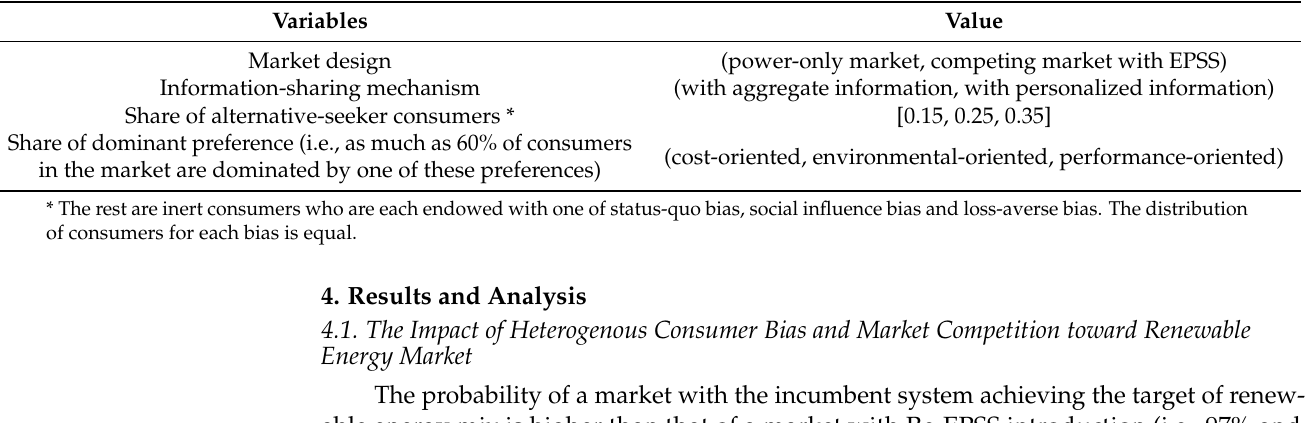
Figure 3. Market condition effect on storage capacity. On the other hand, EPSS deploying batteries as part of their service exert an impact on increasing storage capacity in the long term. Figure 3 shows that lower storage capacity is associated with low EPSS market share. This suggests that EPSS not only stimulate in- vestment in PV facilities but also in electricity storage. The more EPSS uptake in the mar- ket, the more reserve capacity available that will be advantageous for supply security.